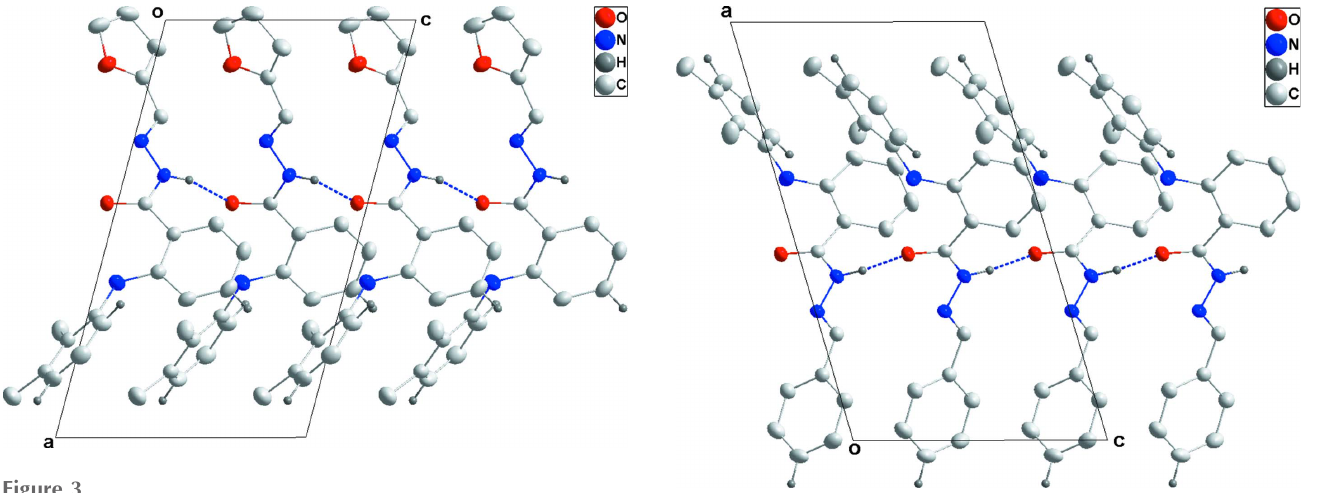
Figure 5 A portion of the N—H (cid:2)(cid:2)(cid:2) O hydrogen-bonded chain viewed along the b axis of (II) with hydrogen bonds shown as dashed lines..